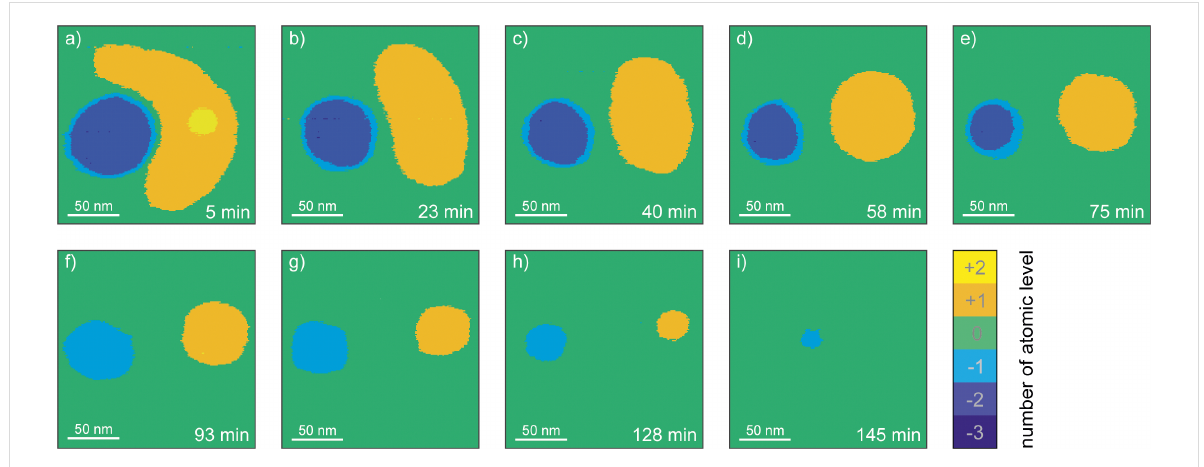
Figure 8: 200 nm × 200 nm sections of the time evolution of the scratching site at RH = 28.2%. Each image is measured within 17.5 min starting about 5 min after the creation. The initial rectangular scratching site adopts in a few minutes a circular form. Similarly the material accumulation erodes faster on the sharp margins and also adopts a circular form. The small second layer erodes after some minutes. The hole, already after a few minutes is largely two atomic layers deep. The accumulation completely erodes some minutes faster than the deepening. Measurement parameters: f 0 = 32873 Hz, A = 500 pm, Δ f = 20 Hz.